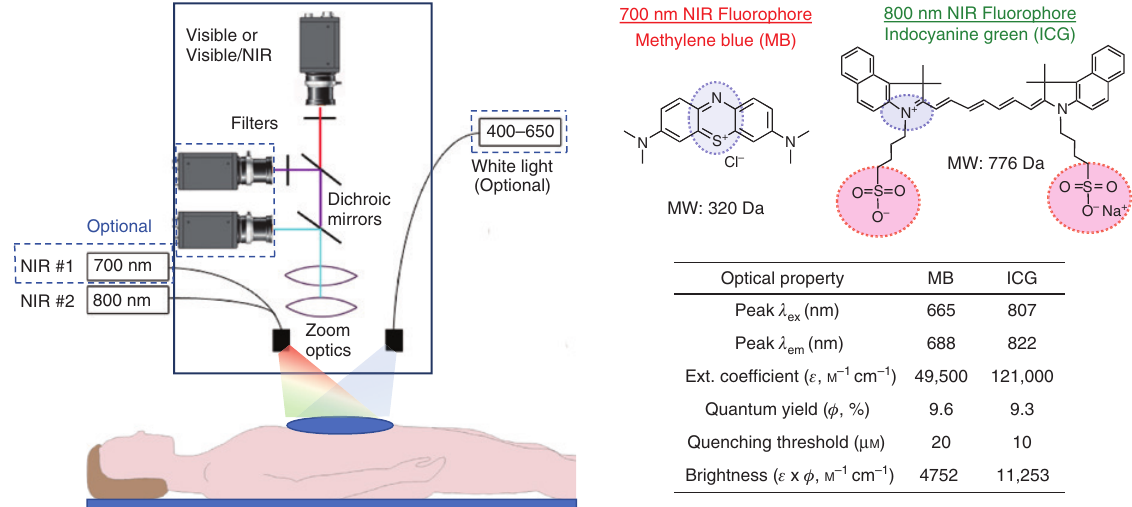
Figure 2: Real-time image-guided surgery using a multichannel NIR imaging system combined with currently available NIR fluorophores in clinical